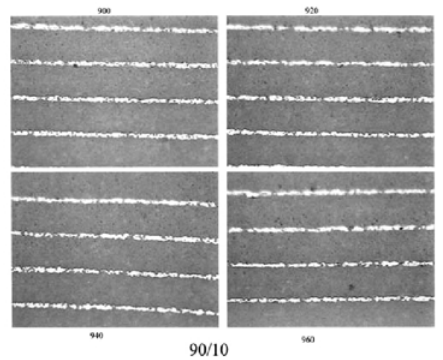
FIGURE 8 Capacitor layers produced with a 90:10 Ag =